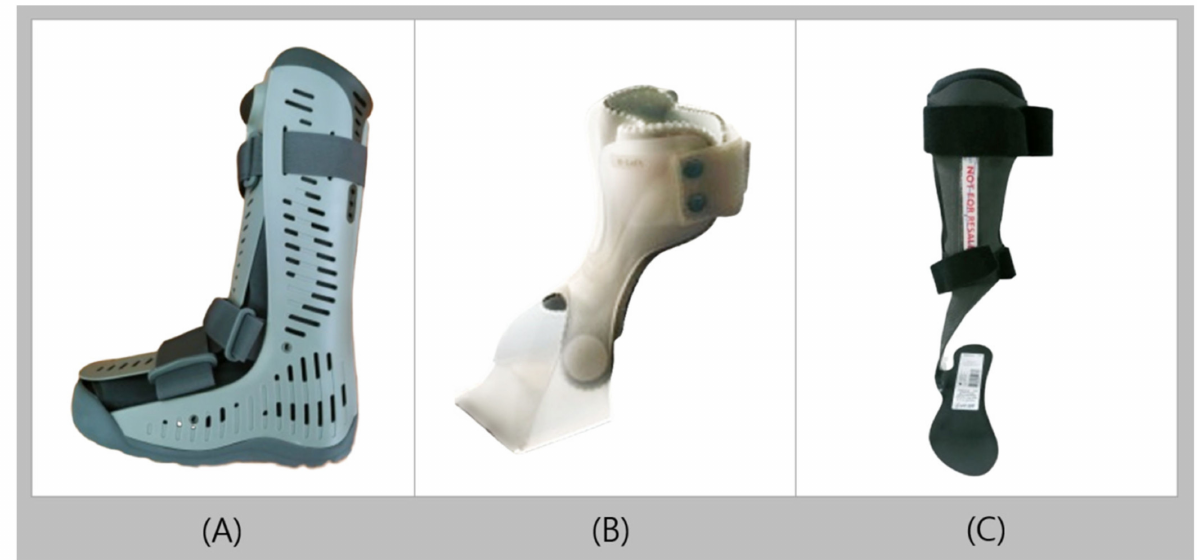
Figure 3. Conventional ankle-foot orthoses ( A ): walking boot, ( B ): UD-Flex, and ( C ): carbon fiber ankle-foot